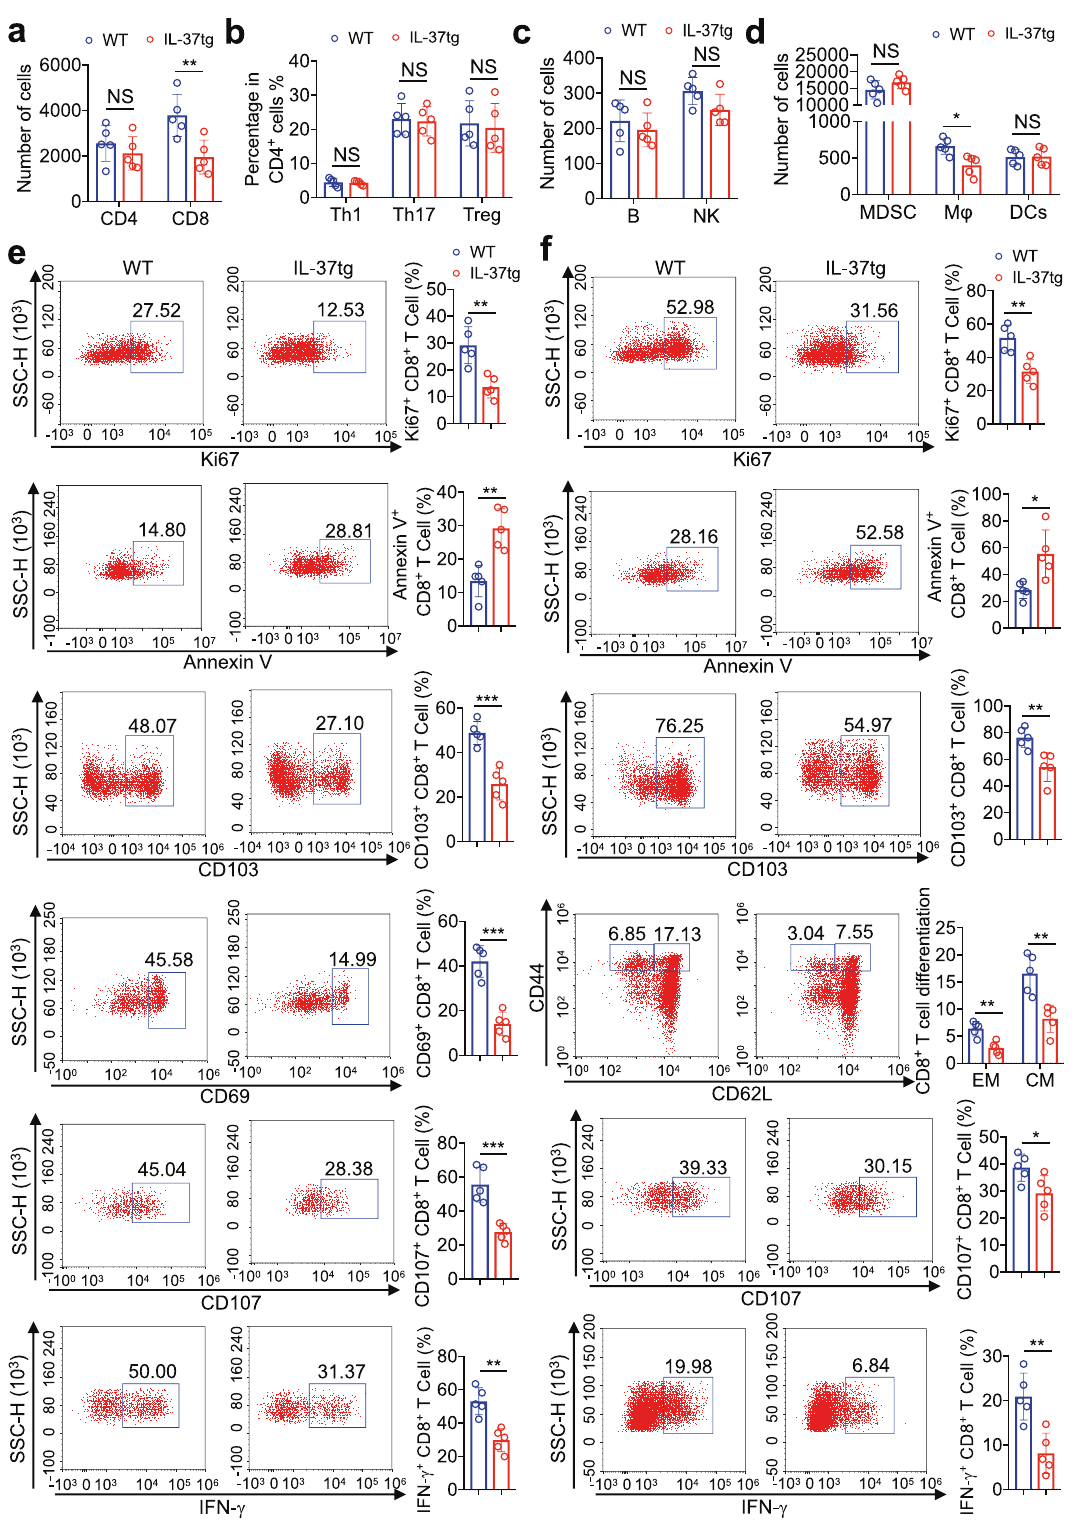
liver tumor growth via converting pSmad3 isoform pathway from pSmad3L tumor-promoting signal to pSmad3C tumor-suppressing signal. 27 These results can be drawn that overexpression of IL-37 has negligible effects on proliferation, apoptosis and motility of colon carcinoma cells at rest